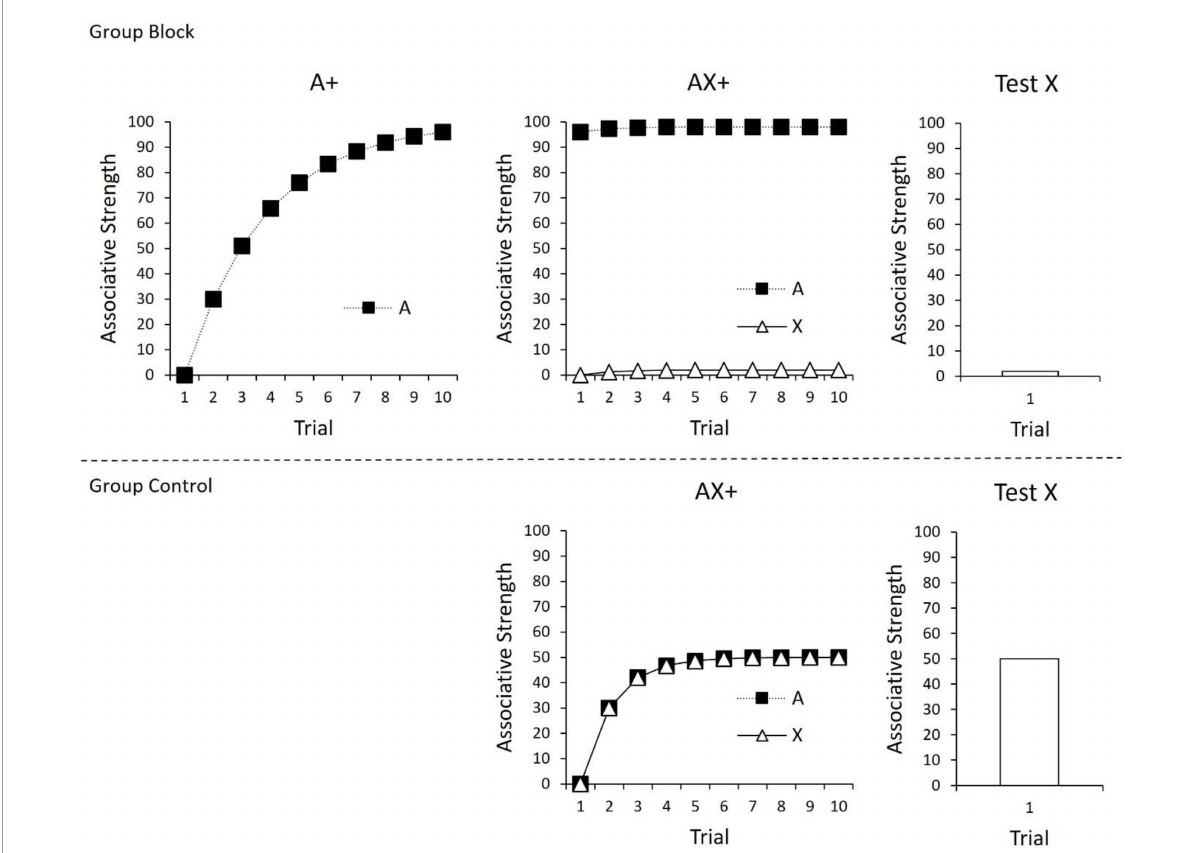
FIGURE1 (Top) Conditioning of A in Phase 1 (left panel) , followed by compound conditioning of AX in Phase 2 (middle panel), and finally a test of X (right panel) . As a consequence of prior conditioning to A, X gains little associative strength. (Bottom) Compound conditioning of AX+, followed by a test of X. In this case, there was no prior conditioning of A, leading X to gain considerable associative strength. For all panels, changes in associative strength were calculated using the Rescorla-Wagner model (1972), (cid:49) V = α × β × ( λ – (cid:54) V), with α × β = 0.3 and λ =